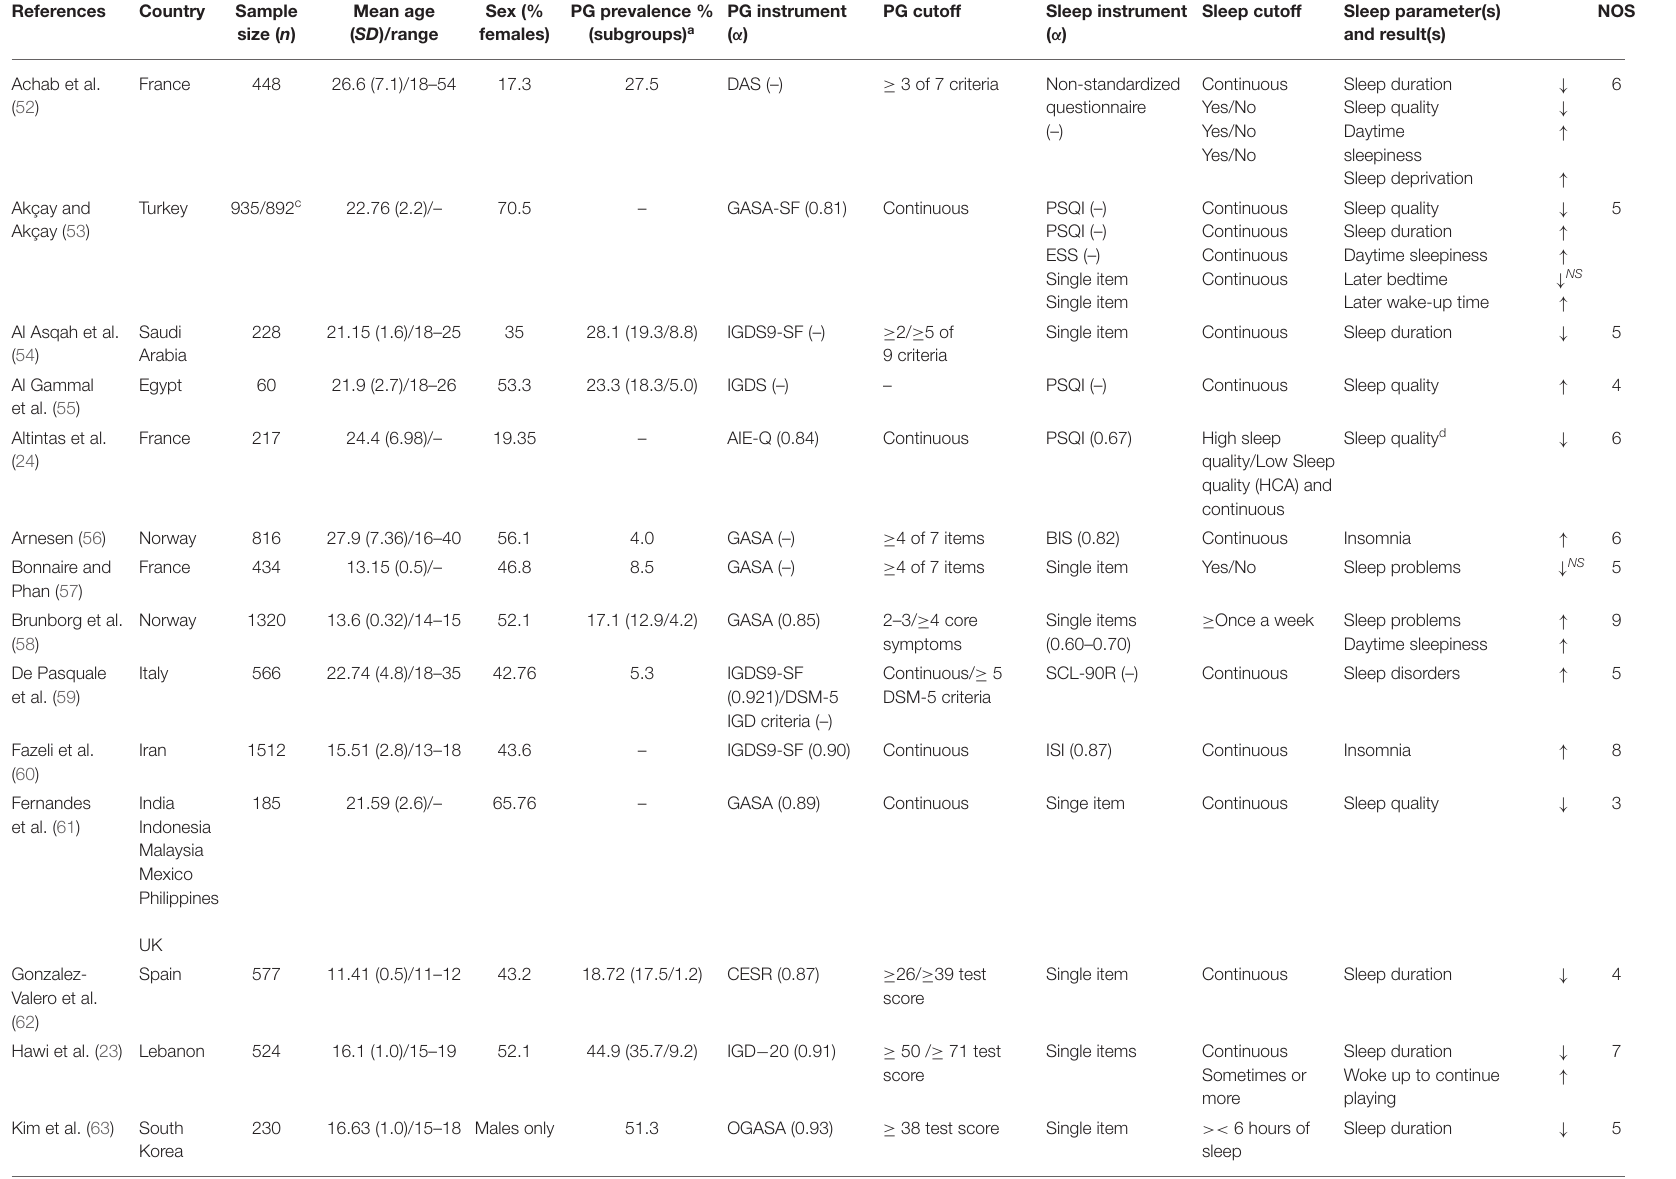
TABLE 2 | Study characteristics and